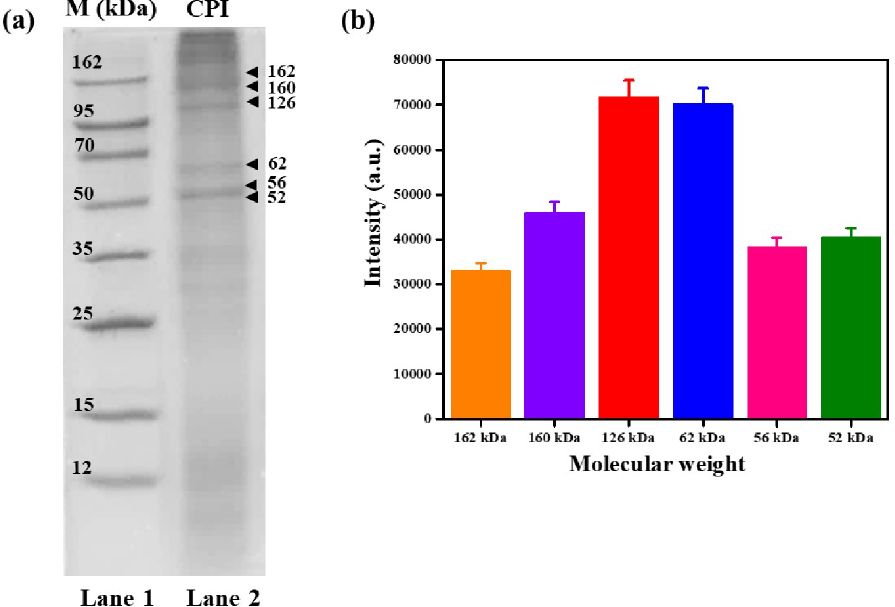
Fig 2. Determination of molecular weight of CPI. (a) SDS-PAGE analysis of total CPI, (b) SDS-PAGE band intensity profile of total CPI.